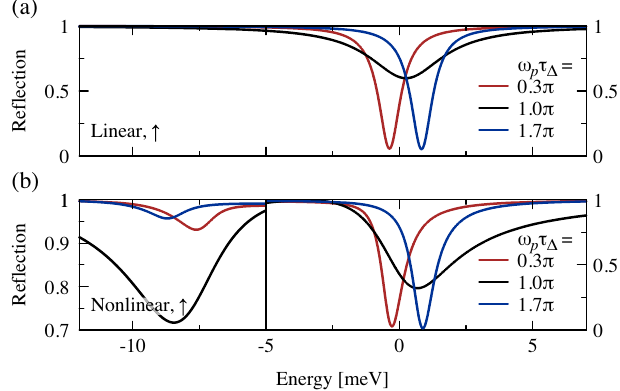
FIG. 9. (a) Linear (pulse area Θ → 0 ) and (b) nonlinear (pulse area Θ ¼ 0 . 05 π ) reflection spectra for linearly ( ↑ ) polarized excitation with 40 fs pulses (intensity FWHM) for a monolayer of MoS 2 at 5 K for different feedback phases ω and 1 . 7 π . The laser pump energy ℏ ω the exciton resonance energy ϵ τ 1 . 0 π . ω Δ ¼ p τ 2 π , where the reflection vanishes. Δ ¼ p